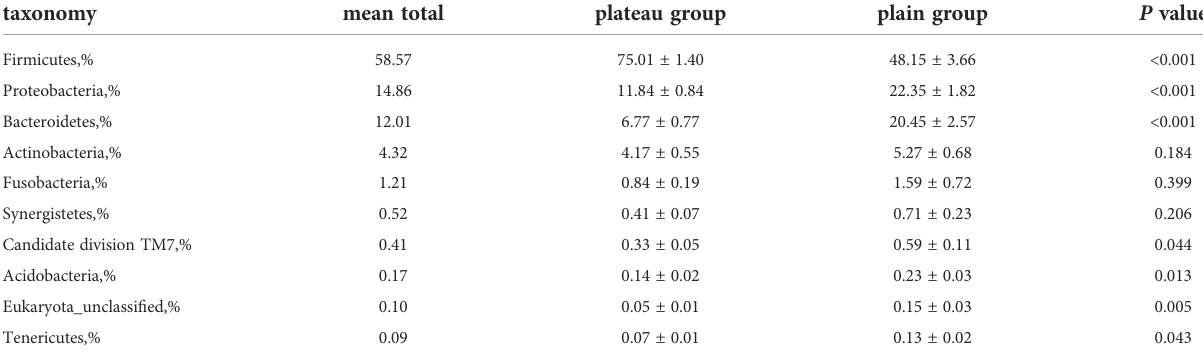
TABLE 2 Comparative table of the abundance of each phylum between two groups (top 10